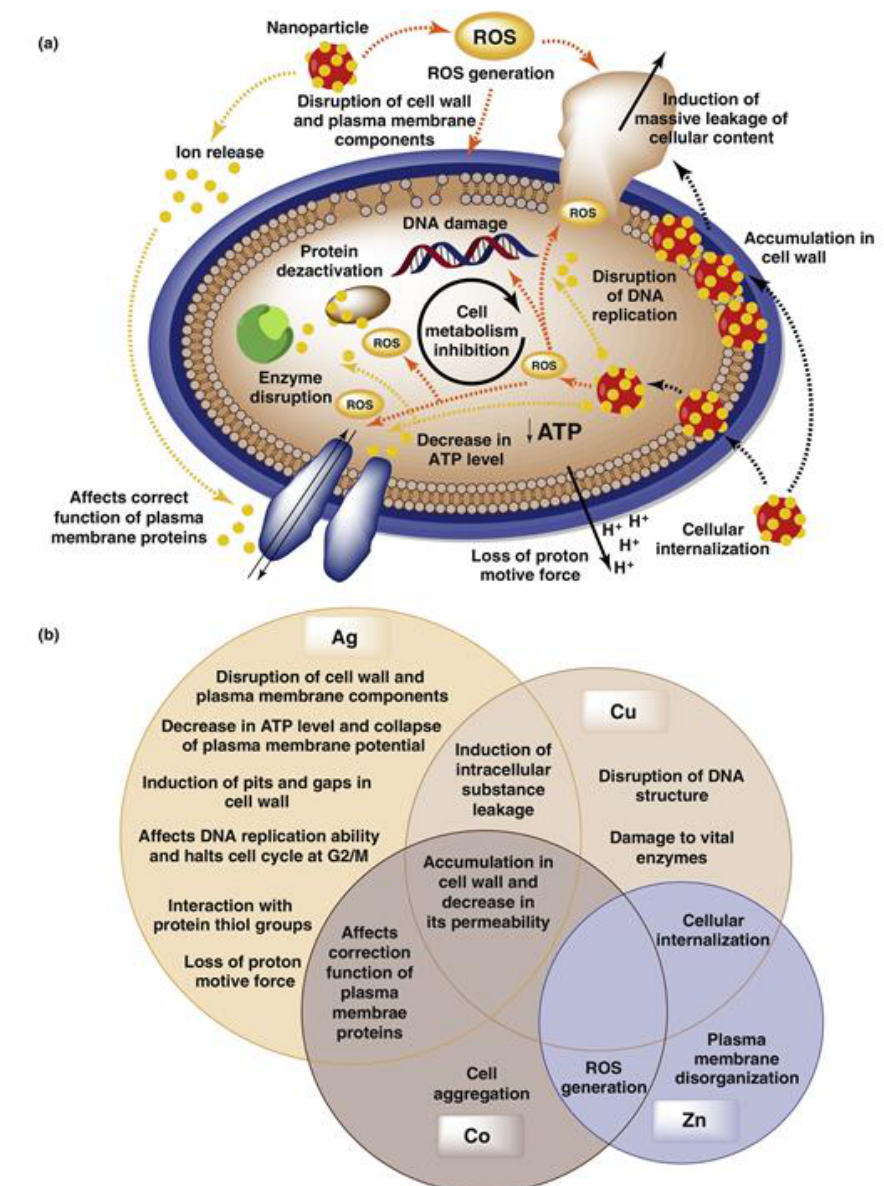
Figure 3. ( a ) Graphical depiction of the possible antimicrobial mechanisms of metal nanoparticles. ( b ) Effect of different metal nanoparticles (e.g. Ag, Au, Zn, Co) on the microorganisms. Taken from Wyszogrodzka et al. [21].